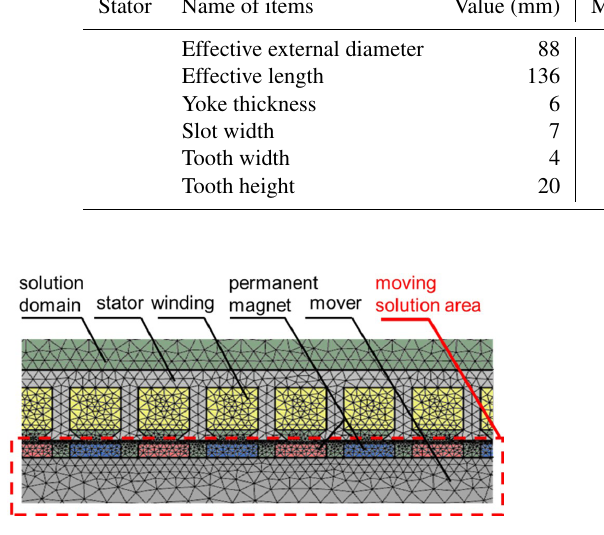
Figure 7. Finite element